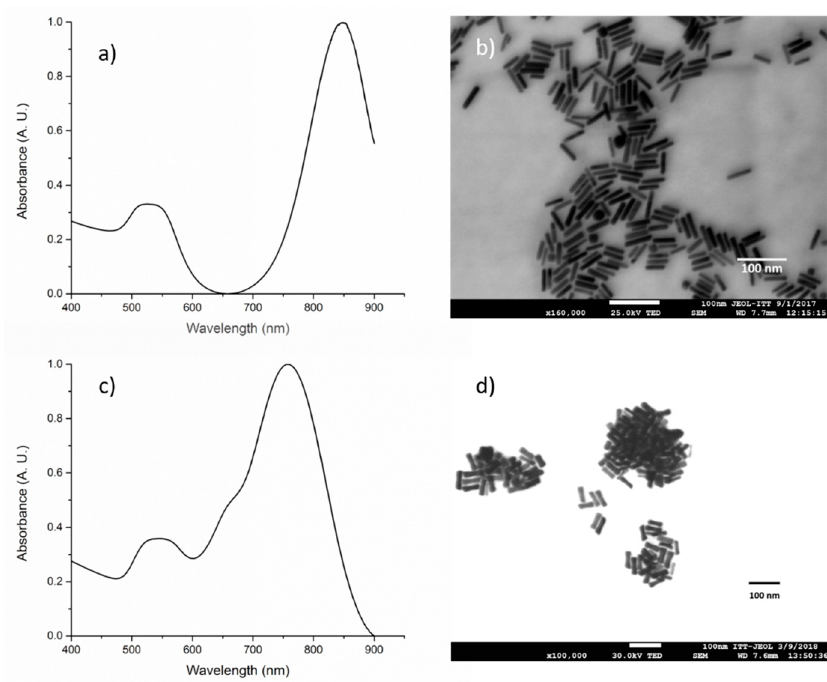
Figure 7. Gold nanorod’s characterization: ( a ) UV-Visible spectrum, ( b ) FE-SEM micrograph for the gold nanorods synthetized from 2-h-aged gold seeds, ( c ) UV-Visible spectrum, and ( d ) FE-SEM micrograph for the gold nanorods synthesized from 8-h-aged gold